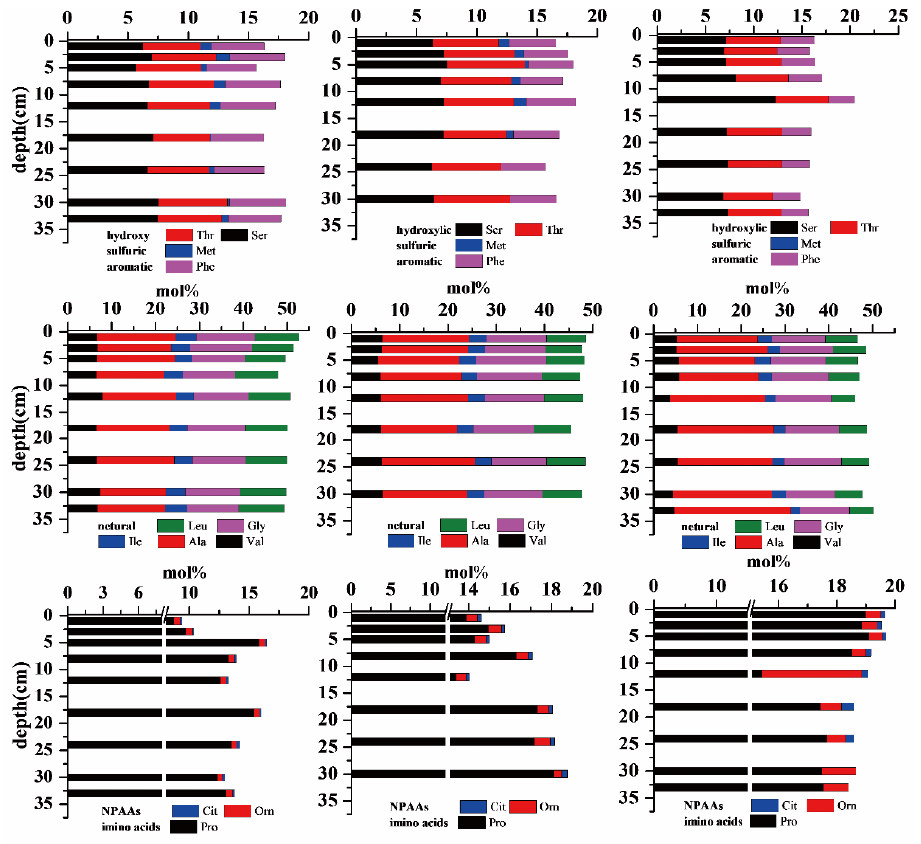
Figure 5. Concentration of THAAs and mole percent of amino acids in sediment cores.